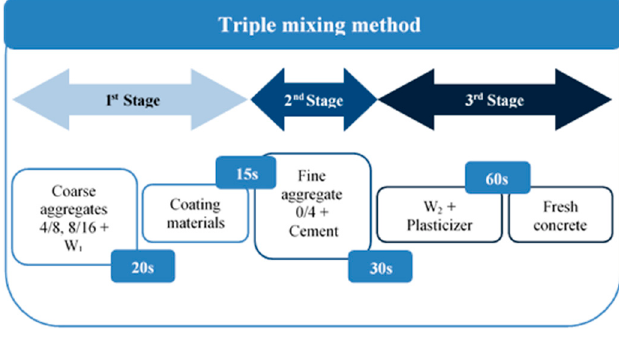
Figure 1. Experimental triple mixing procedure.